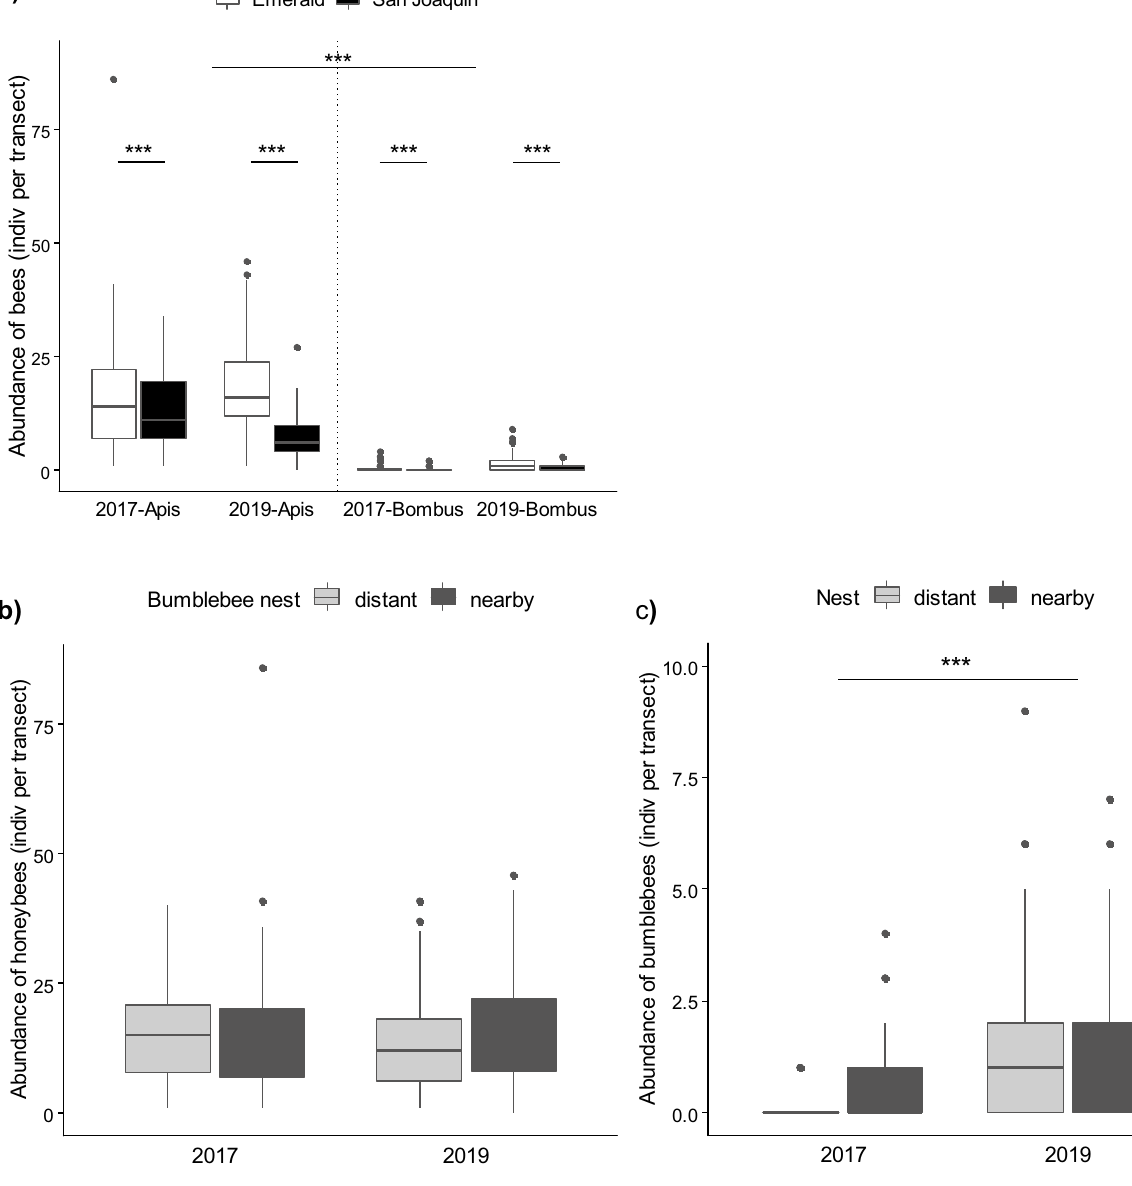
Figure 1. Foraging patterns of Apis mellifera and Bombus pauloensis at population level on ‘Emerald’ and ‘San Joaquin’ cultivars. (a ) Abundance of individuals per transect. Honeybees far outnumbered bumblebees but did not vary between years. ( b , c ) Abundance of honeybees ( b ) and bumblebees ( c ) per transect, considering the proximity to a bumblebee nest. The density of honeybees differed between cultivars but was not affected by the proximity to a Bombus colony. The number of bumblebee foragers increased with a high stocking density of colonies but was not affected by the presence of a nest nearby. Boxplots show the median and interquartile range (IQR), with whiskers showing the maximum value within 1.5 IQR, and individual points mark values outside this range. Asterisks indicate statistical differences (***, p < 0.001). (N = 369 presented more blueberry pollen on their bodies (across all three evaluated areas) than nectar-foragers (Fig. 3a, Apis vs Bombus : p < 0.001; Nectar- vs Pollen-foragers : p < 0.01). The analysis of pollen loads on the main regions of the body evaluated revealed a significant interaction between species and region (Fig. 3b, species * body region, LR = 12.87, p < 0.001). While the number of tetrads carried by honeybees did not differ among the three body parts evaluated, bumblebees carried significantly more blueberry pollen on their head (post hoc comparison for Bombus : Head vs Legs: p < 0.05, Head vs Thorax-abdomen: p < 0.0001). The amount of pollen on the head of bumblebees doubled that on their legs and surpassed over 8 times that on the thorax-abdomen region (mean ± SE, Head: 202 ± 53 tetrads, Legs: 102 ± 42 tetrads, Thorax-Abdomen : 23 ± 7 tetrads). To assess floral constancy, we monitored a total of 82 honeybees and 85 bumblebees sequentially visiting on average (mean ± SE) 10.7 ± 0.9 (3–41) and 18.2 ± 1.7 (3–73) blueberry flowers, respectively. When we evaluated